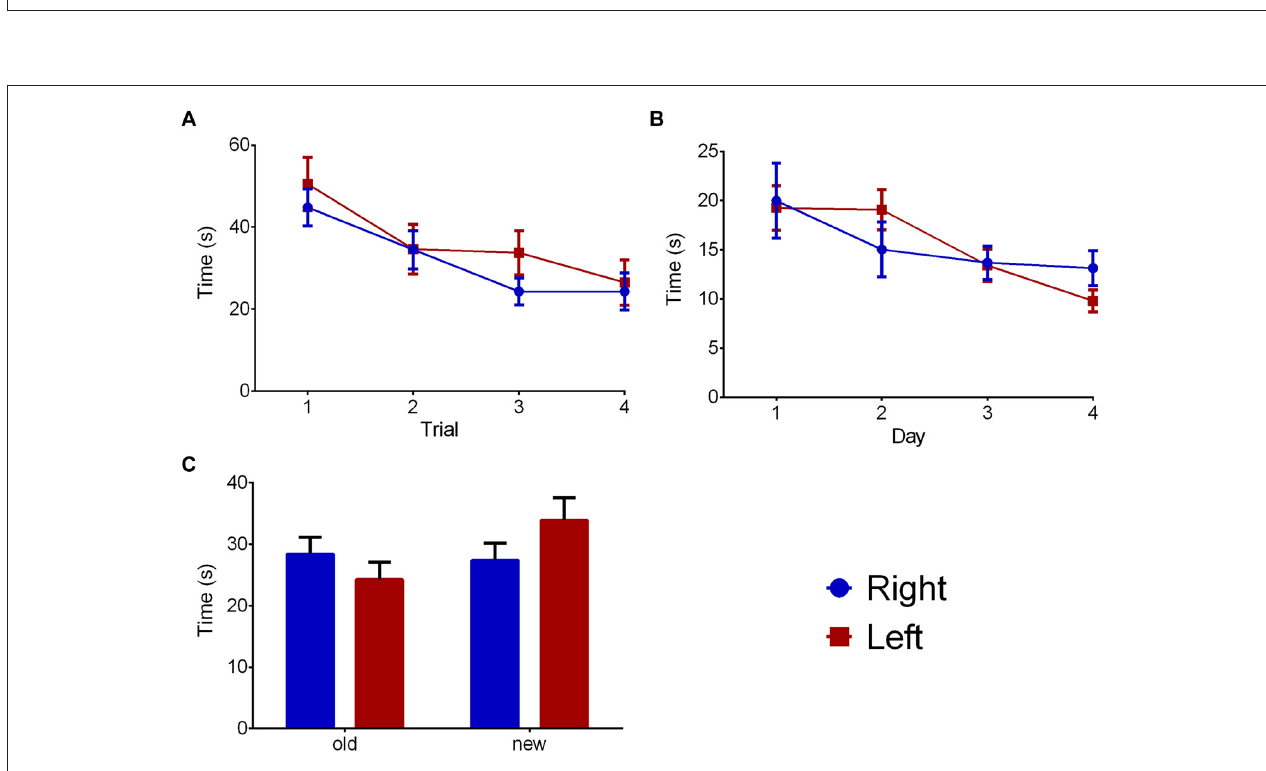
FIGURE 5 | Group effects on memory. Group comparison on the water maze test in WM (A) , classic Morris (B) and reversal (C) components. Data is shown as mean ± SEM. Blue—animals with right paw preference; Red—animals with left paw preference.